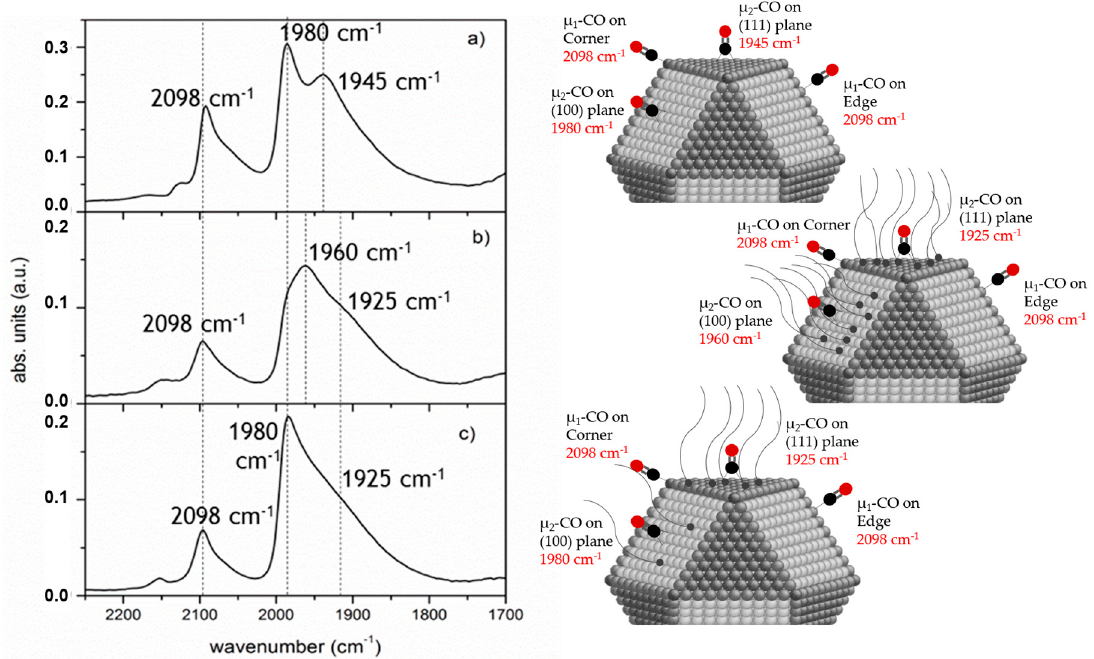
Figure 7. DRIFT spectra of adsorbed CO on ( a ) naked and protected Pd NPs ( b ) before and ( c ) after calcination. Reproduced with permission from ref. [68]. Copyright2016, American Chemical Society.